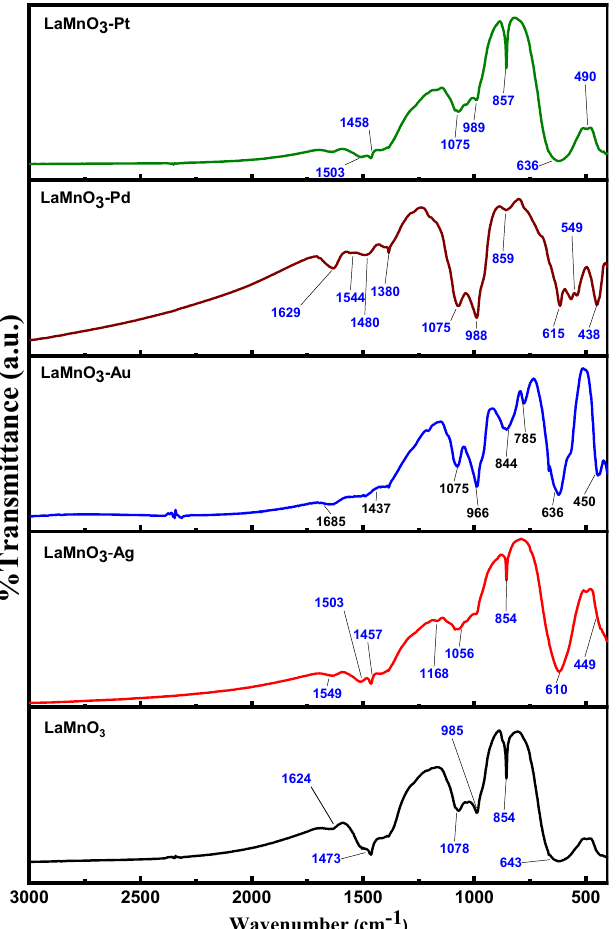
Figure 3. FT-IR spectra for the bulk and noble metal deposited LaMnO 3 nanocomposites. The morphology and particle sizes of different phases in the synthesized nanocom-